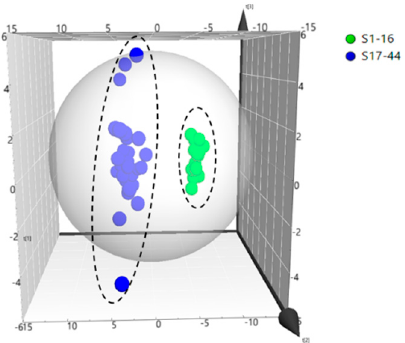
Figure 2. Score scatter plot by PCA processed data acquired from samples. Each of the blue circle represented a batch of LJF, the green circle represented a batch of LJC.